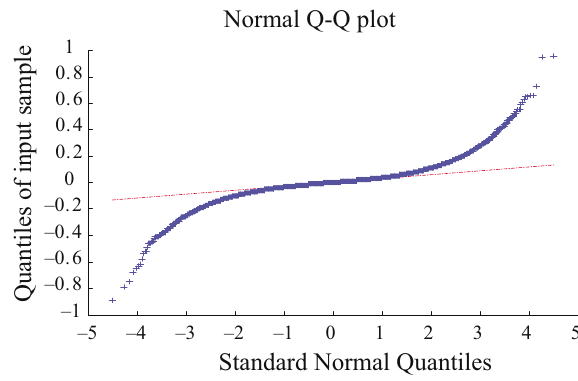
Fig. 2. Normal quantile – quantile plot for the error distribution together with the theoretical normal distribution for the DEM with 0.5 meter resolution. The plot shows considerable deviation from a straight